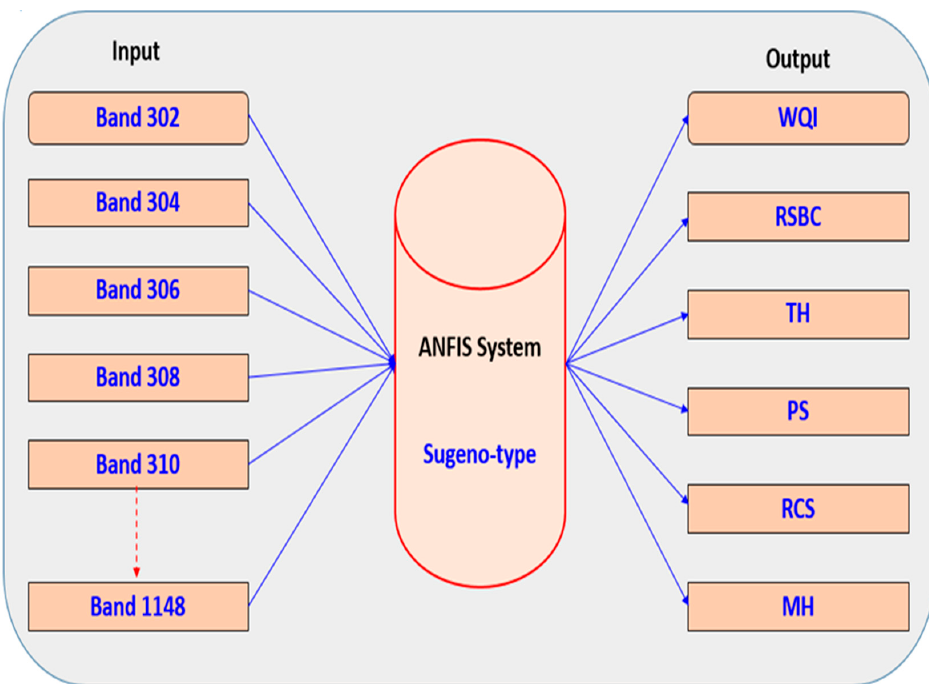
Figure 4. An ANFIS architecture for prediction of groundwater quality variables. WQI, RSBC, TH, PS, RSC, and MR indicate water quality index, residual sodium bicarbonate, total hardness, potential salinity, residual sodium carbonate, and magnesium hazard, respectively.